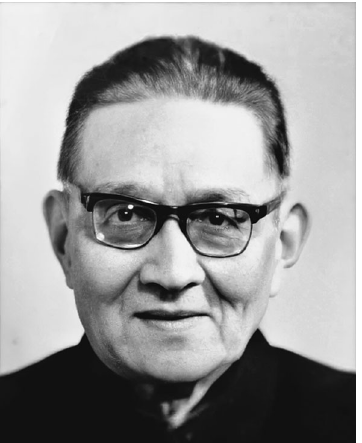
Figure 1. Chi-Nan Hu (1905 – 1989).